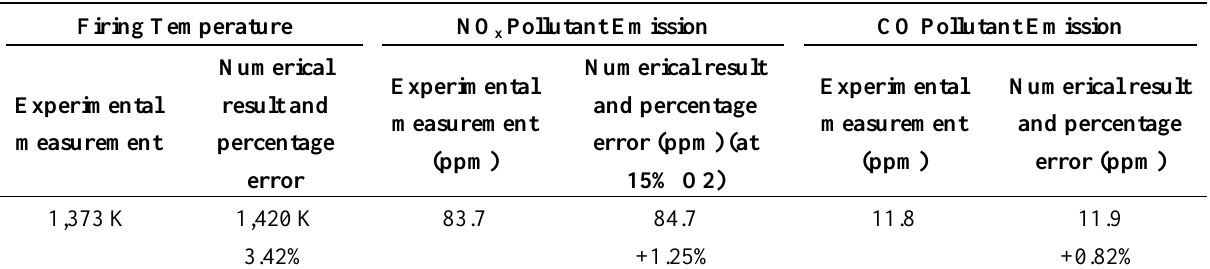
Table 6. Comparison between experimental and numerical result at 100% load and ISO